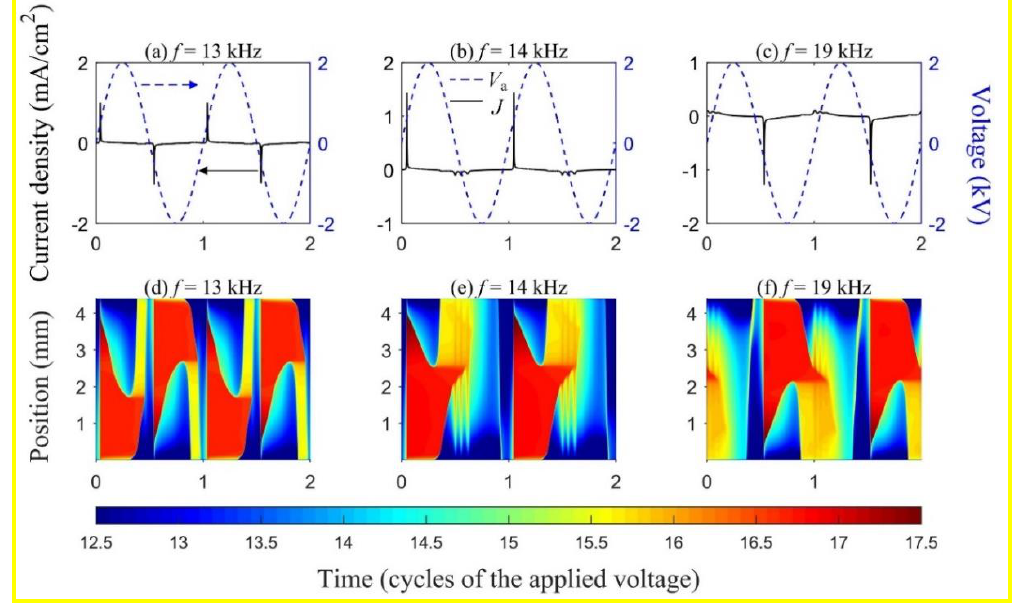
Figure 3. Waveforms of the total discharge current density ( a – c ) and the corresponding spatiotemporal distributions of electron density ( d – f ) under different driving frequencies. The voltage amplitude V am , gap width d g , and dielectric thickness d b are fixed at 2 kV, 4.4 mm, and 1 mm, respectively.